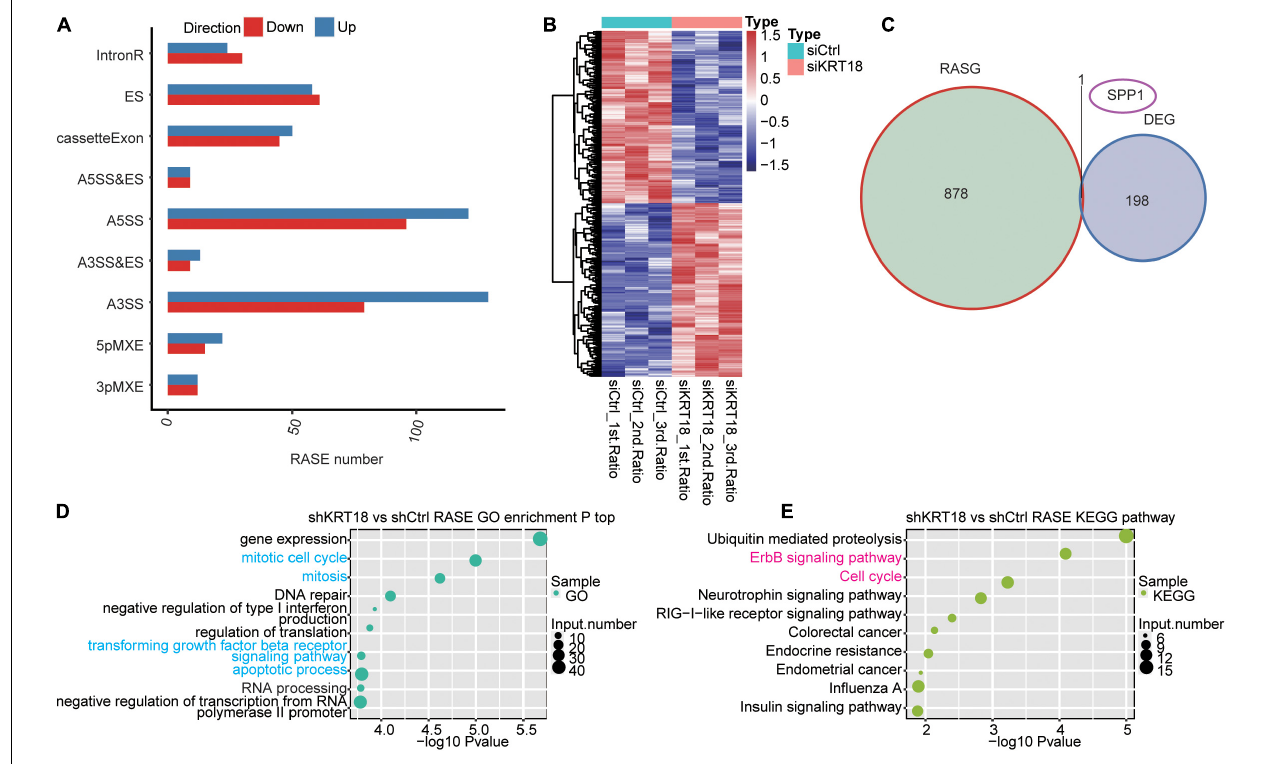
FIGURE 2 | Analysis of KRT18-regulated alternative splicing in AGS cells. (A) Classification of KRT18-regulated alternatively spliced events in AGS cells. (B) Heatmap presenting AS ratio pattern of KRT18-affected ASEs. (C) Venn diagram shows the result of overlap analysis between KRT18-regulated differentially expressed genes (DEGs) and alternative splicing genes (RASGs). (D) The top 10 GO biological process terms and (E) KEGG functional pathway of the alternative splicing genes are shown in bubble